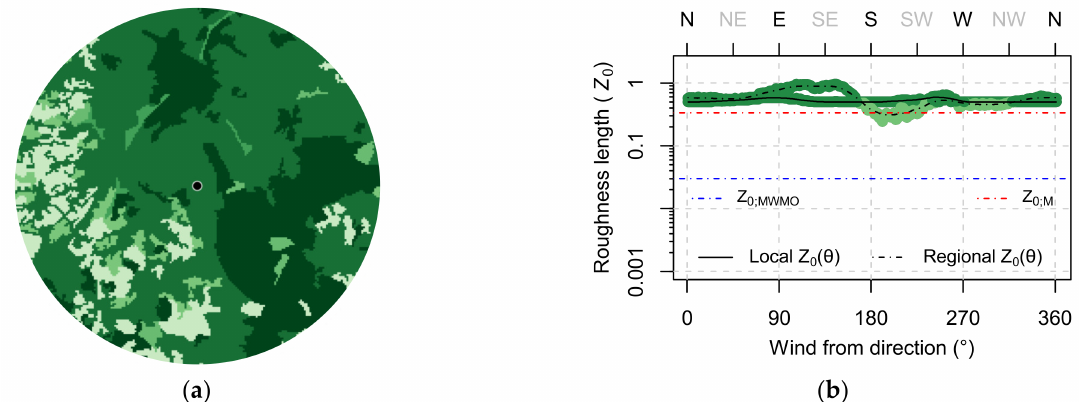
Figure 22. Derived surface roughness for UKULE site ( a ) in 10 km radius adapted from CLC map 2 ; ( b ) Directional local and regional surface roughness weighted by distance to building-site. Darker green colour indicates higher surface roughness